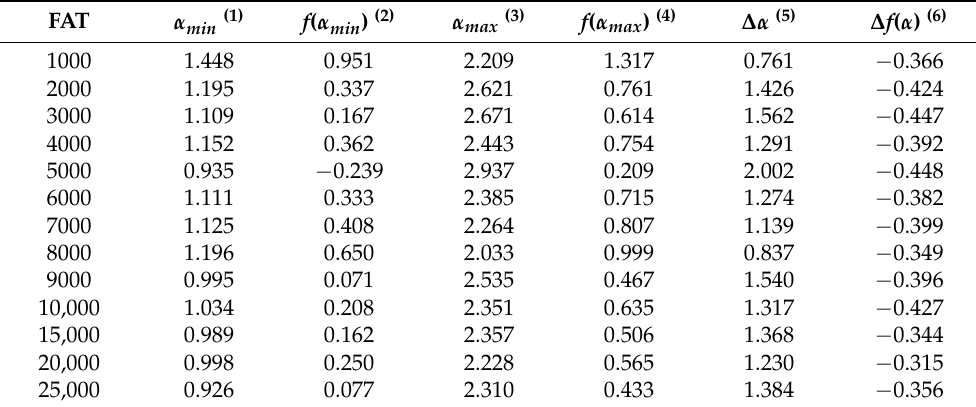
Table 7. Calculated parameters of the multifractal method (Hubei Province).